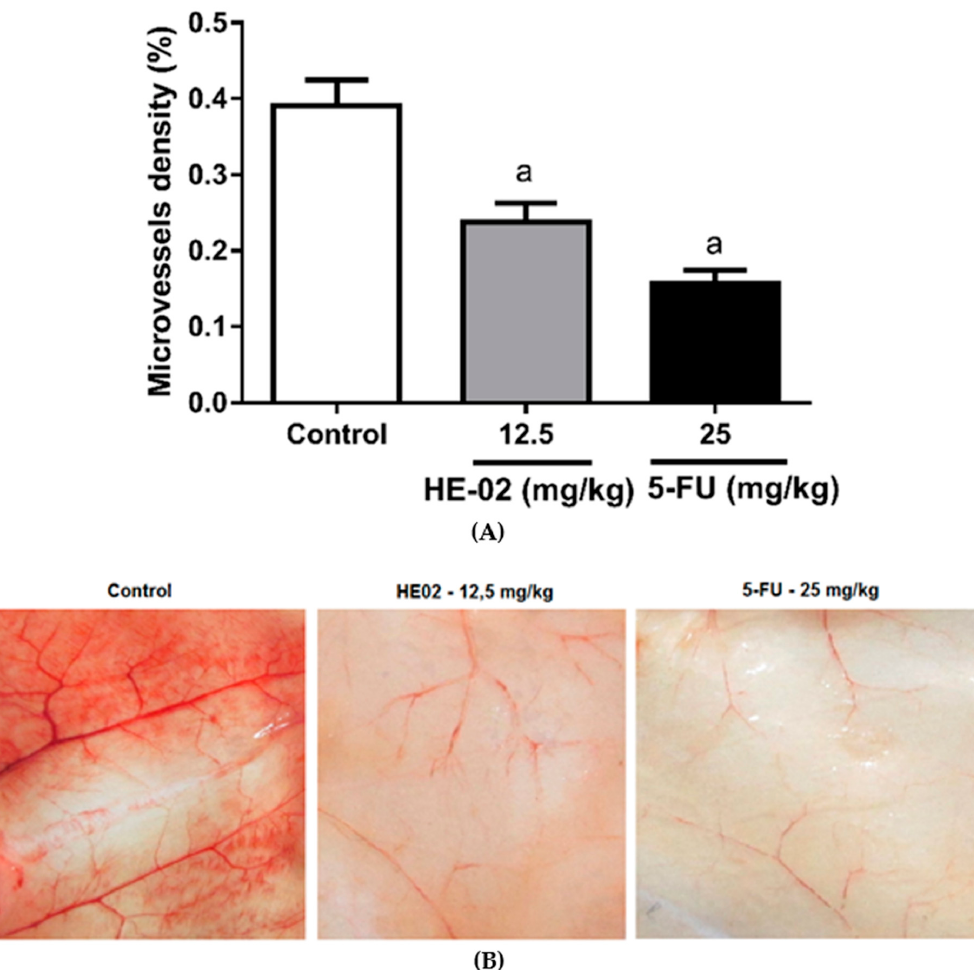
Figure 3. Effects of HE-02 and 5-FU on microvessel density (%) in mice transplanted with Ehrlich tumor, after 9 days treatment. ( A ) Microvessel density (%) represents the blood vessel area per field in selected vascularized areas divided by the whole area. ( B ) Representative images of animals’ peritoneum cut into standard size (1 cm × 1 cm) showing the reduced neovascularization by HE-02 and 5-FU treatments. Data presented as mean ± SEM of six animals analyzed by ANOVA followed by Tukey test. a p < 0.05 compared to tumor control group.